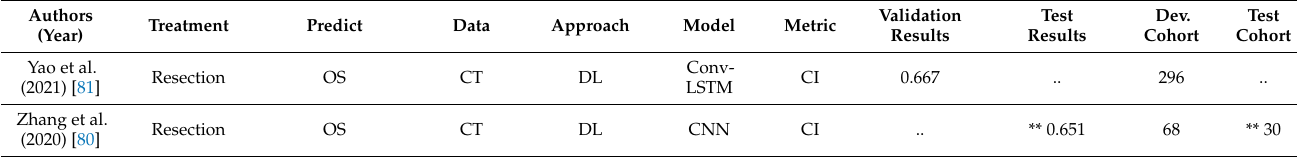
Table 4. Summary of papers on AI for PDAC treatment response prediction. The performance for the validation and test sets is reported with respective 95% Confidence Interval or standard deviation when it was